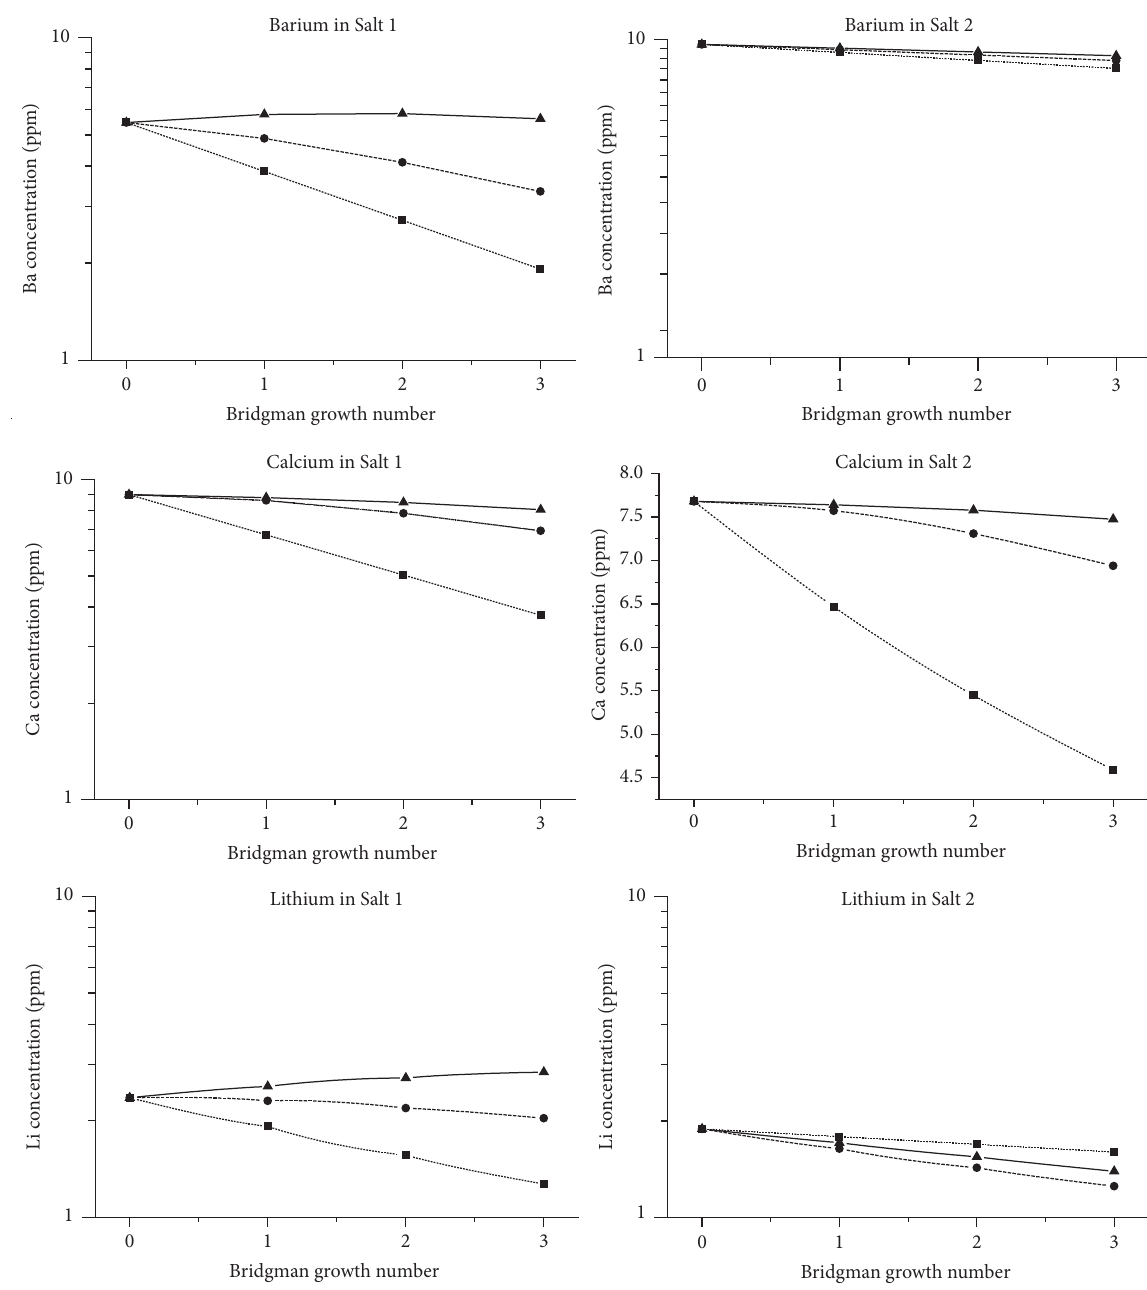
Figure 4: Concentration of impurity ions in different regions of crystals. ◼ bottom region: compartment 𝐶 1 ; e middle region: compartment 󳵳 top region: compartment 𝐶 𝐶 2 ; 3 . Values were calculated theoretically from model described in Figure 1 and (7), (8), and